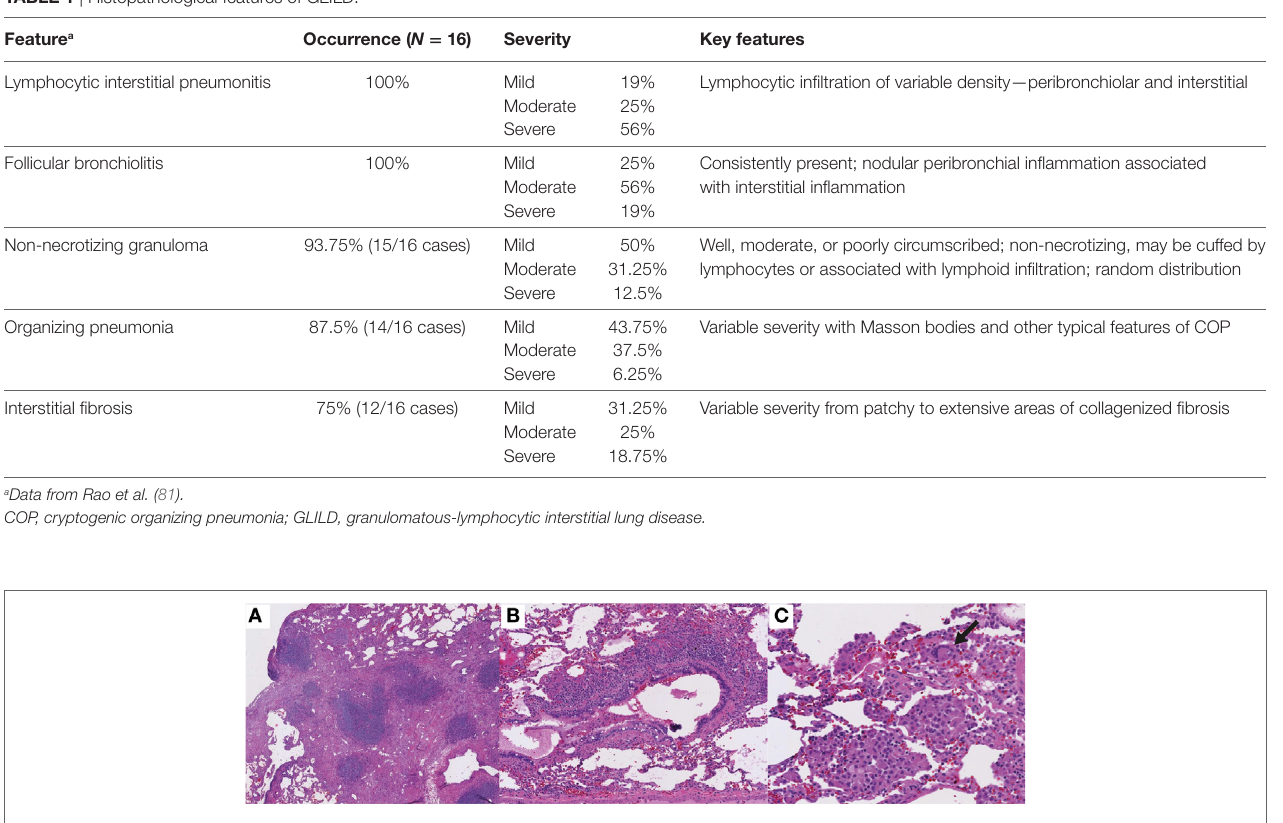
TABLe 1 | Histopathological features of